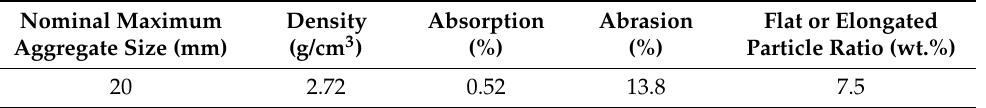
Table 5. Properties of the